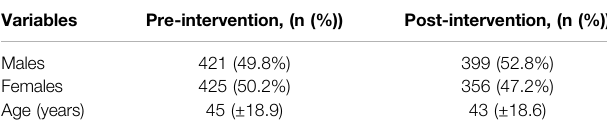
TABLE 1 | Demographic characteristics of study patients. Variables